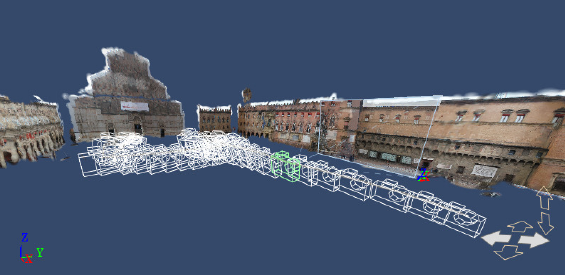
Figure 7. Maggiore Square, Bologna, Manual